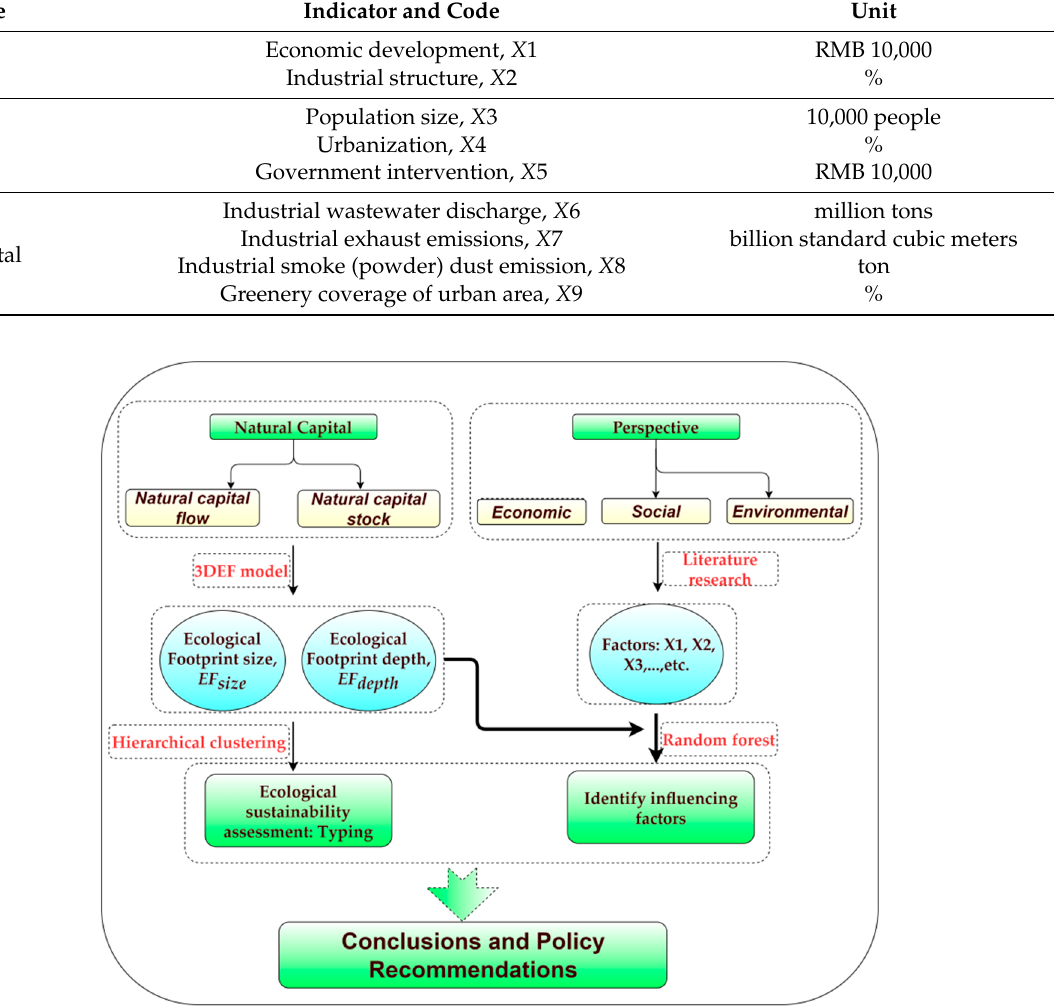
Table 3. Socioeconomic and environmental indicators of the CUA.